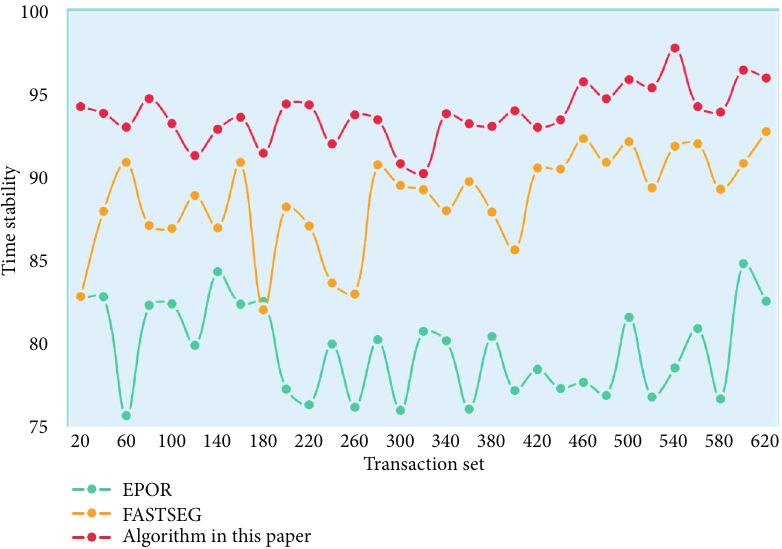
Figure 8: Experimental results of time